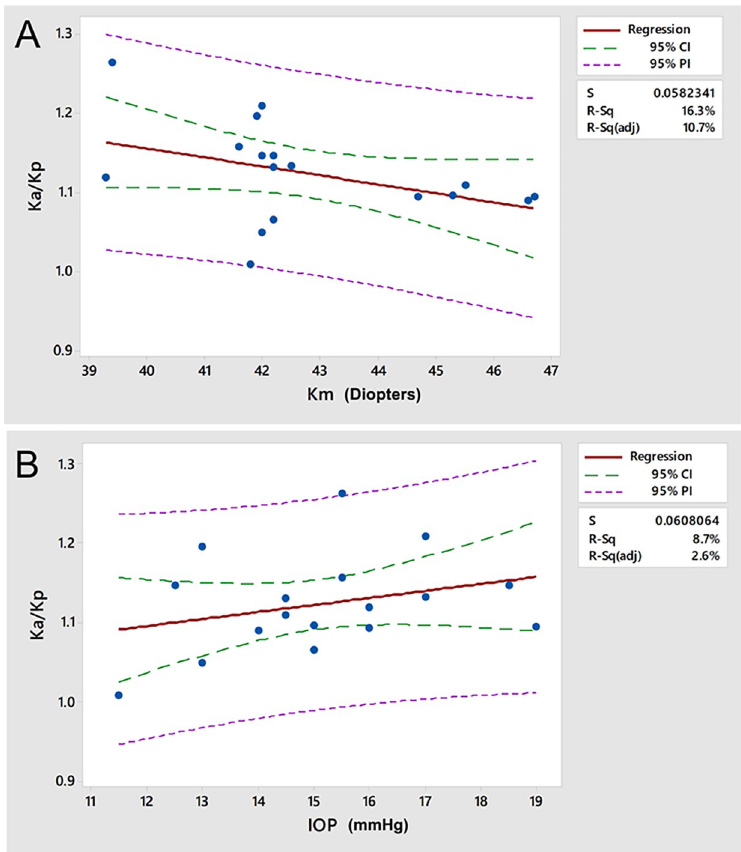
Fig 3. Linear regression results between k a /k p (the anterior/posterior stromal response ratio) and A ) the mean anterior corneal curvature and B ) IOP for all eyes. Despite a trend toward lower with increasing corneal curvature, neither correlation was statistically significant. S = standard error, R-sq = coefficient of variation, CI = confidence interval, PI = prediction interval.